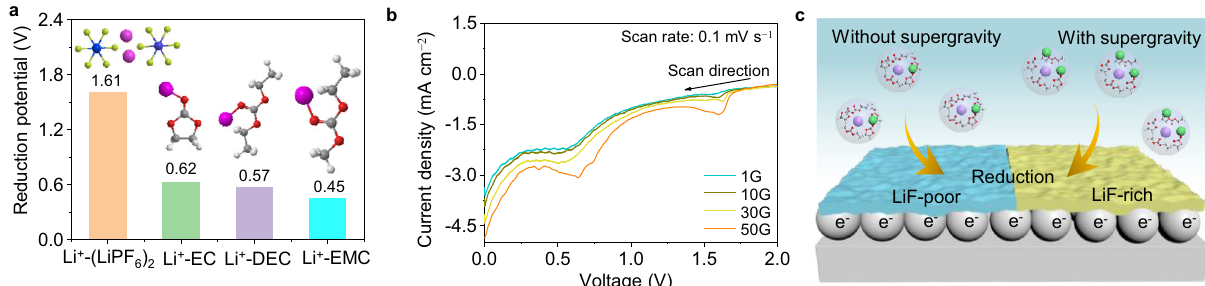
Fig. 5 The formation mechanism of SEI under different gravity conditions. a Reduction potentials of optimized Li + -solvent and (LiPF 6 ) 2 complexes calculated based on quantum chemistry. b Typical CV curves of Li | |Cu cells under different gravity coef fi cients. c Schematic illustrations of the SEI formation process. Color code: Li + purple, PF 6 − green, F orange, P blue, C gray, O red, H white.